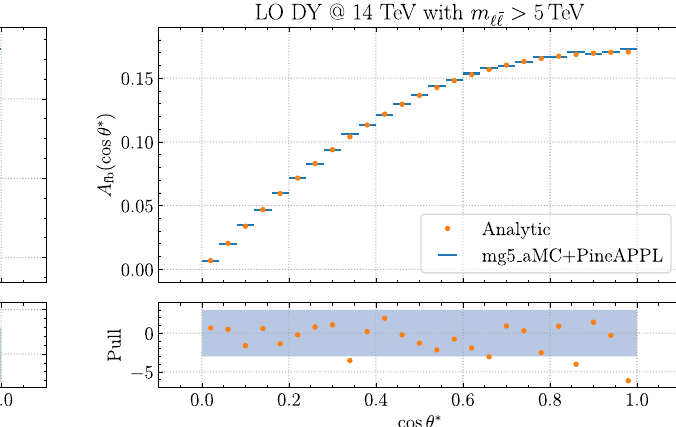
play the difference between the analytic and numerical calculations rel- ativetotheMonteCarlointegrationuncertainty.Thebluebandindicates the3 σ uncertaintyinterval.OneofthereplicasoftheNNPDF4.0NNLO PDF set is used as input to the calculation